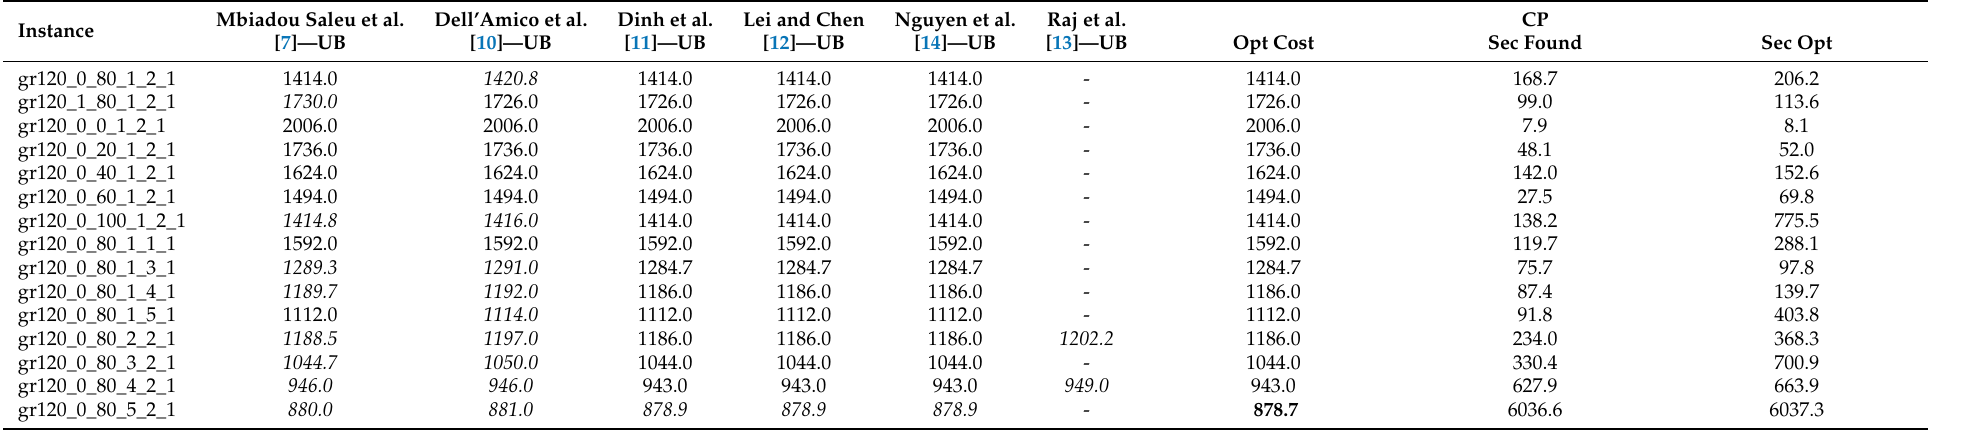
Table 5. Instances originated from gr120 in [7]. Optimal solution